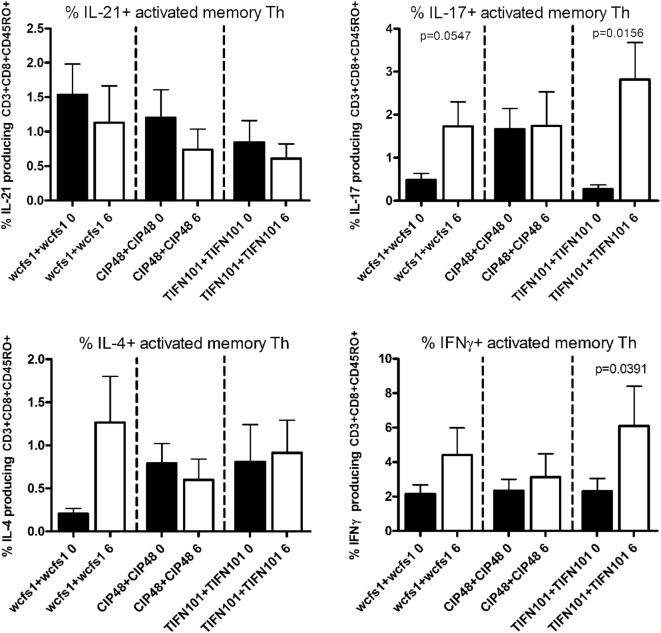
Effects of three Lactobacillus plantarum strains on the frequency of IL-21, IL-17, IL-4, and IFN-γ-producing memory-CD45RO+ Th cells stimulated with bacterial cell extracts, matched to the strain consumed. Data are expressed as mean ± SEM. Statistical significant differences were determined by using two-sided Student’s t-tests. A p-value <0.05 was considered statistically significant. A p-value <0.1 was considered a statistical trend.